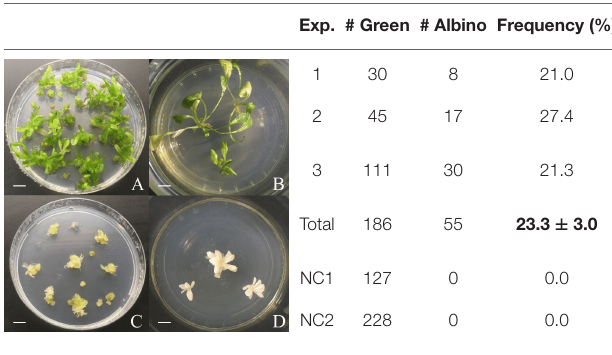
TABLE 3 | Genotype of the ten albino plantlets and their corresponding ploidy